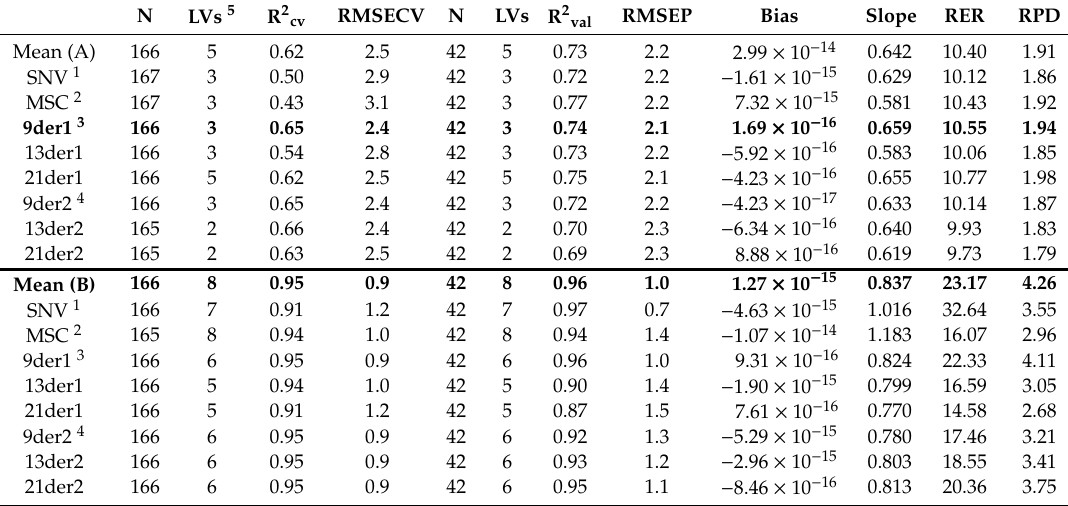
Table 2. Summary of the PLS regression models developed for the prediction of BWC on WD st (A) and WD gr (B). The best models are highlighted in bold. The vertical line in bold is used to divide calibration (on the left) and validation (on the right)